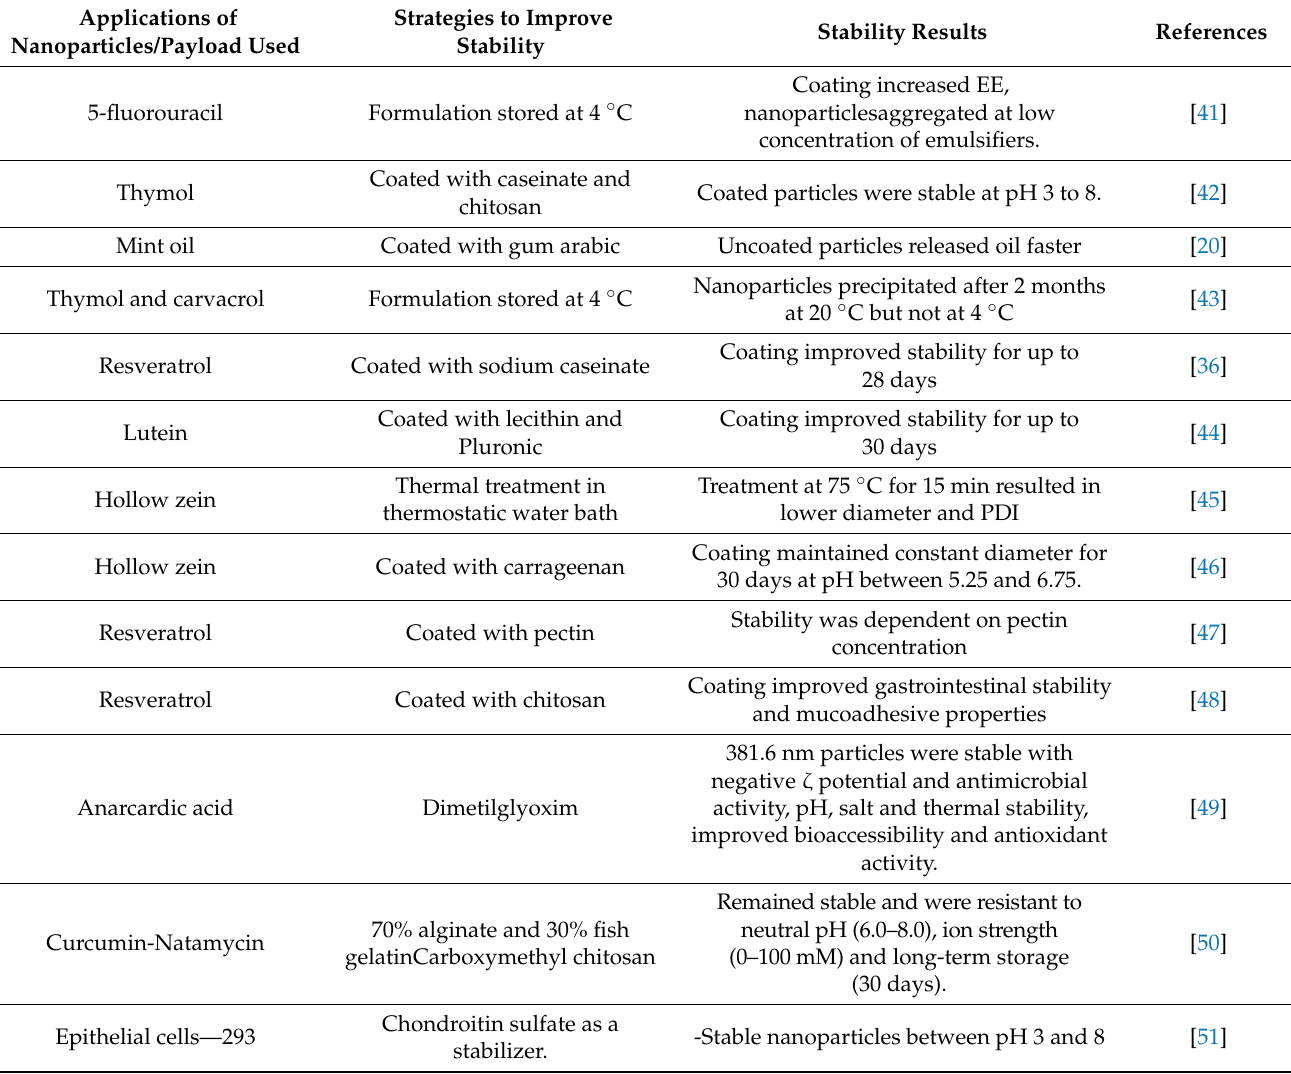
Table 2. Approaches used to improve the stability of zein nanoparticles. Reprinted with permission from ref. [21]. Copyright 2018